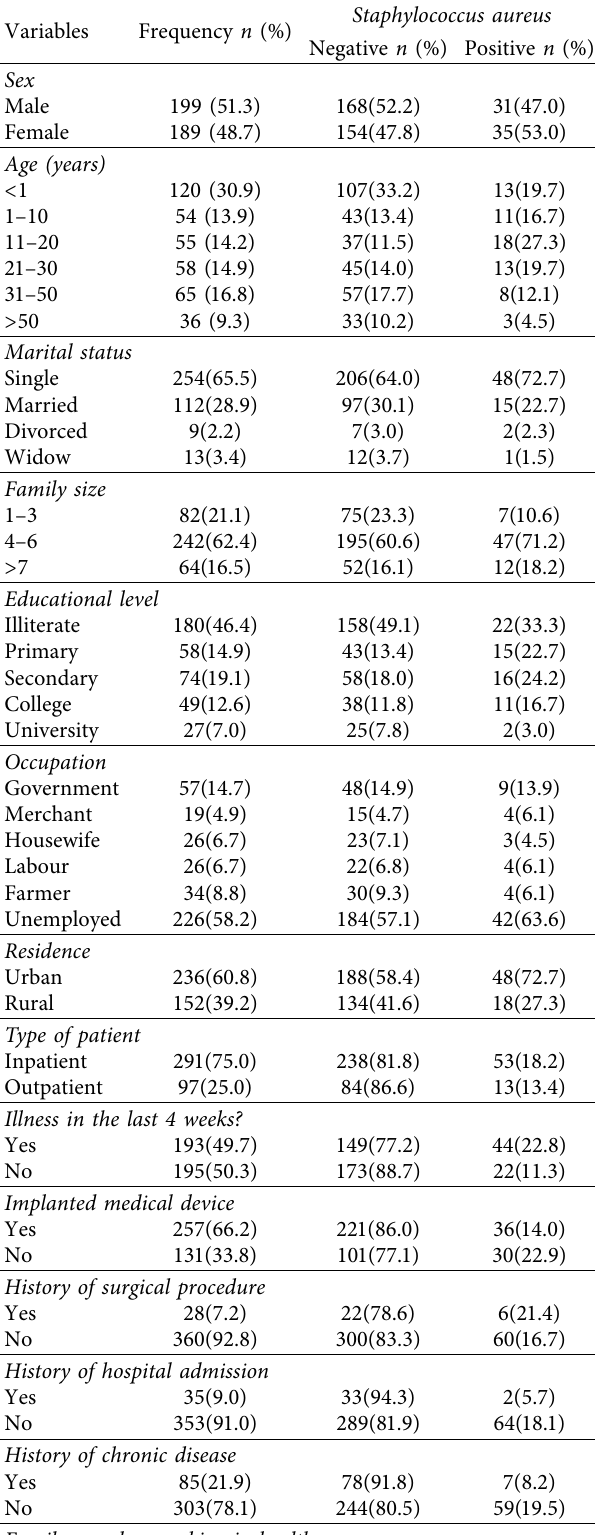
Table 1: Sociodemographic characteristics and associated factors of the study participants with respect to the Staphylococcus aureus prevalence attending University of Gondar Comprehensive Spe- cialized Hospital, Ethiopia,